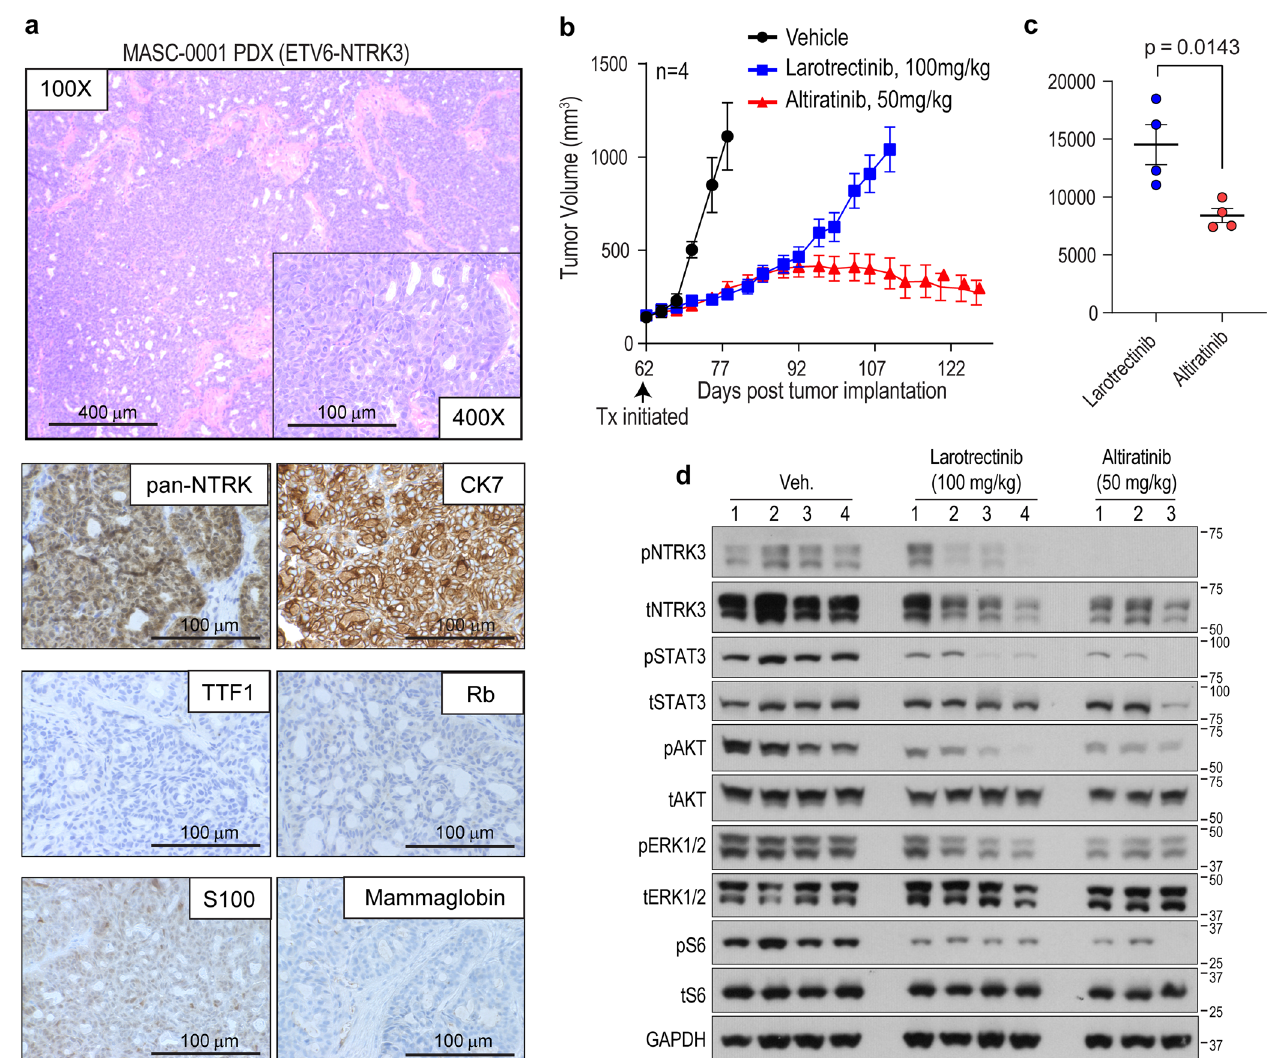
Fig. 3 Altiratinib inhibits growth of ETV6-NTRK3 G623R patient-derived xenograft tumors. a Morphological and immunohistochemical characterization of patient-derived xenograft (PDX) that was established from tumor samples obtained from a MASC patient (MASC-0001) harboring the ETV6-NTRK3 fusion and who developed the G623R mutation after entrectinib treatment. b Mice bearing PDX tumors were treated with larotrectinib (100 mg/kg, twice daily (bis in die, (BID), shown in blue) or altiratinib (50 mg/kg BID, shown in red) as compared to vehicle-treated tumor-bearing mice (vehicle, BID, shown in black). Treatment (Tx) was initiated 62 days post implantation (black arrow) when tumor volume was ~100 – 200 mm 3 . Tumor volume measurements are shown as a function of time. c Area under the curve analysis compares the ef fi cacy of larotrectinib and altiratinib tumors. Average ± standard error of means (SEM) is shown with statistical signi fi cance indicated by p value (unpaired Student ’ s t -test). d Immunoblot analysis of lysates generated from treated tumors (from ( b )). Phosphorylation of ETV6-NTRK3 (pNTRK3), STAT3 (pSTAT3), AKT (pAKT), ERK1/2 (pERK1/2), and ribosomal protein S6 (pS6), as well as corresponding total levels of these proteins and GAPDH (loading control). “ Veh. ” indicates vehicle (DMSO) treatment. Numbers above blots represent separate tumors from individual mice with n = 4 for the vehicle and larotrectinib groups, and n = 3 for the altiratinib group. There was insuf fi cient material from the 4th altiratinib-treated tumor for biochemical